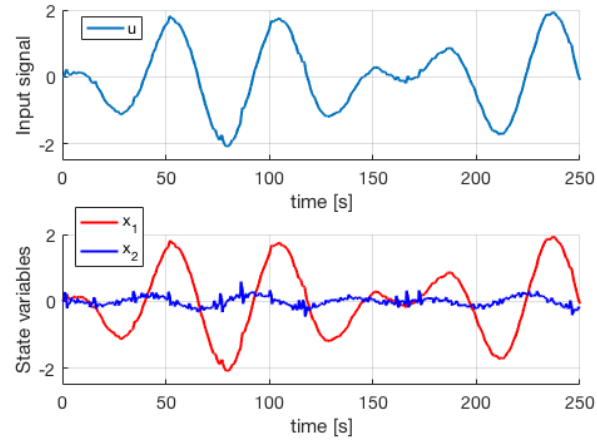
Figure 7. Top : Input signal with random noise; Down : variables of wind turbine system